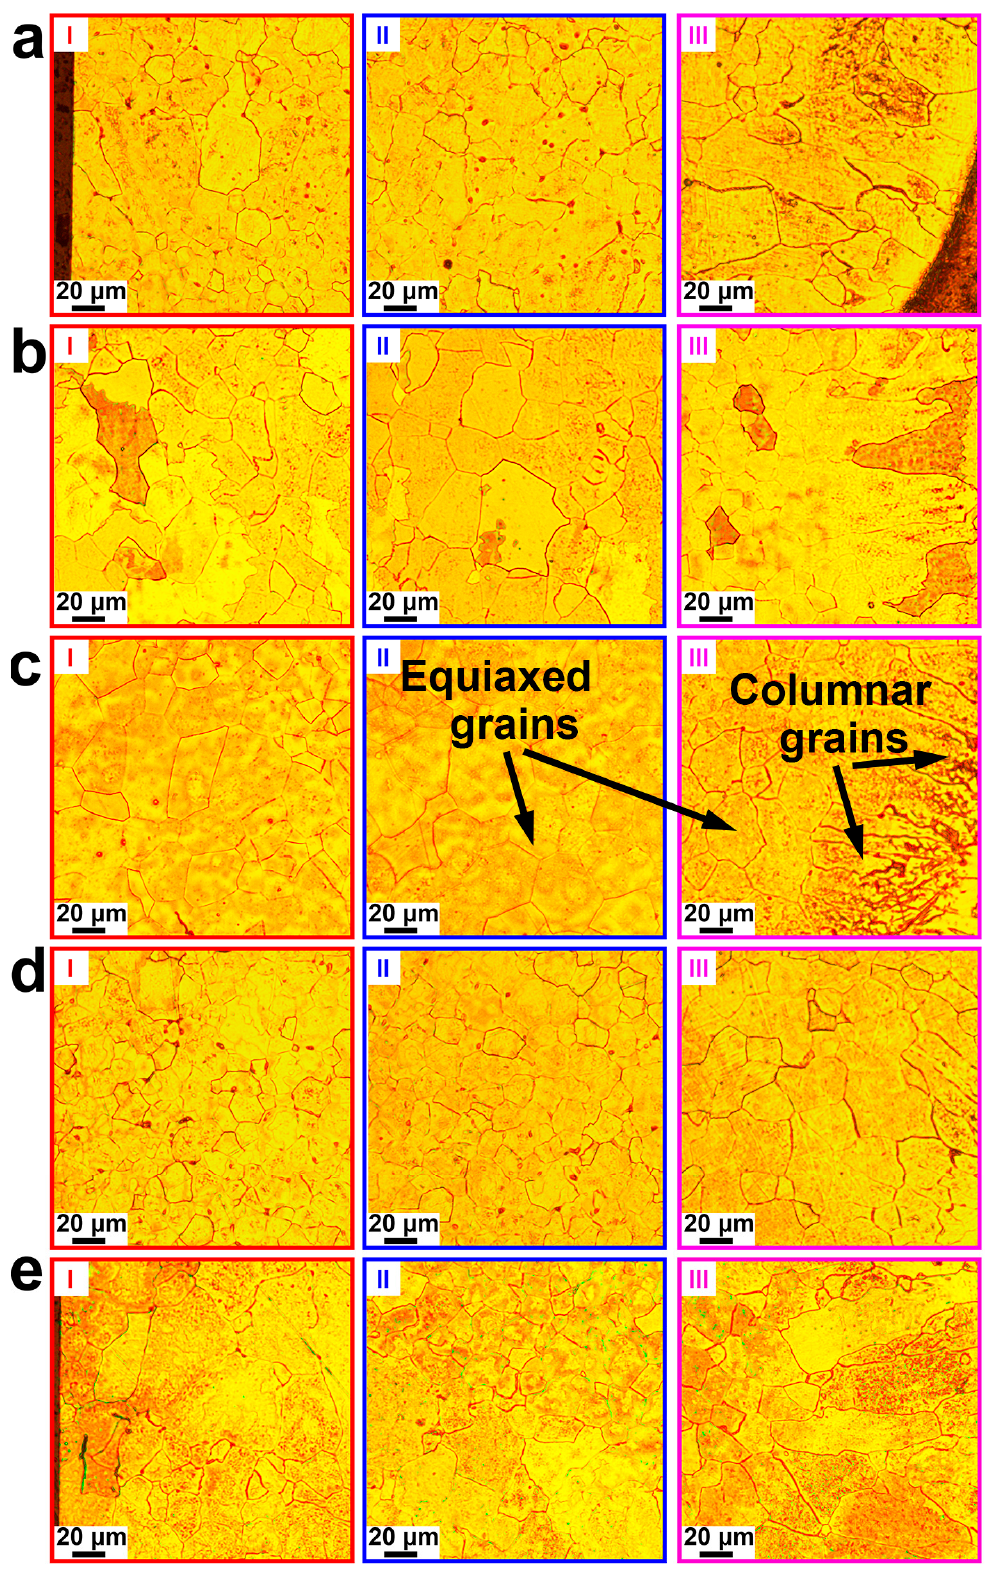
Figure 4. Optical microscope images of the cross-sectional profiles of the cladded layers of ( a ) specimen 1, ( b ) specimen 2, ( c ) specimen 3, ( d ) specimen 4, and ( e ) specimen 5.